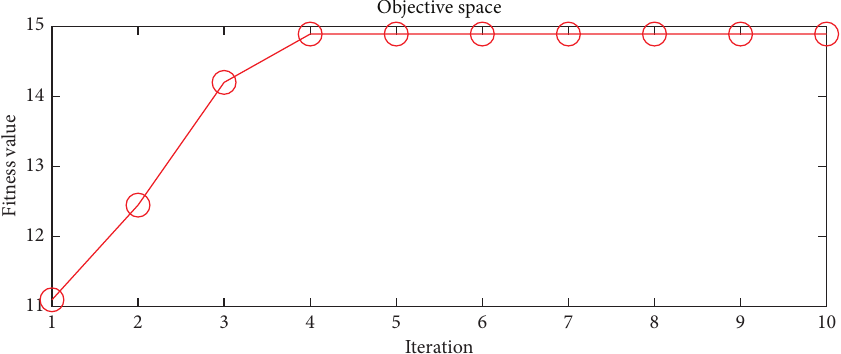
Figure 19: Experimental signals of case 1: PSO convergence curve based on